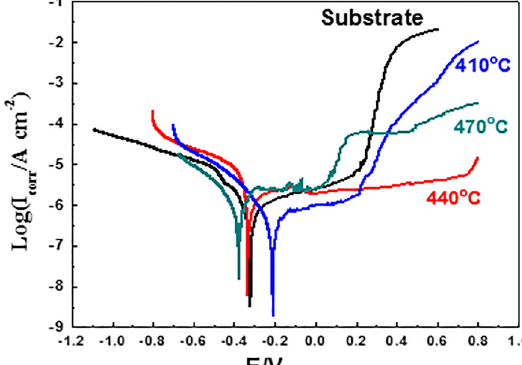
Figure 9 . Potentiodynamic polarization curves of untreated and treated samples in 3.5% NaCl water